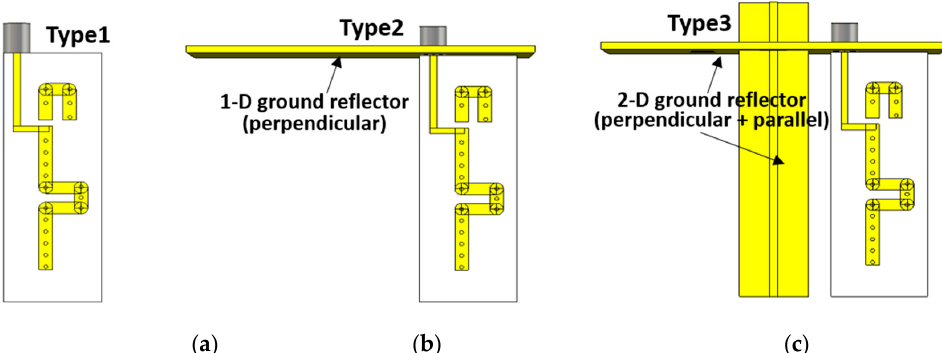
Figure 4. Di ff erent types of planar super J-pole antennas: ( a ) conventional, ( b ) 1D reflector, and ( c ) 2D